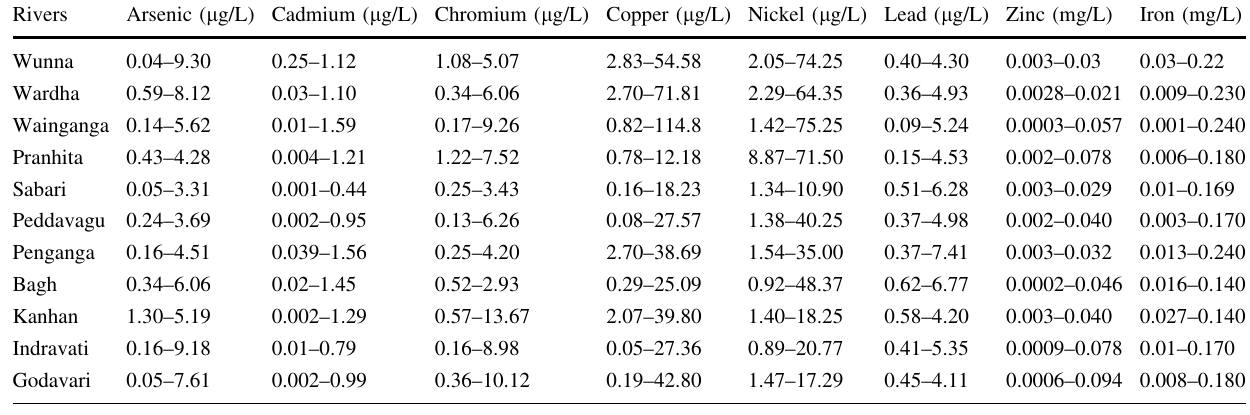
Table 3 Heavy metal distribution in river Godavari and its tributaries (Sept. 2011 to Aug. 2013) Rivers